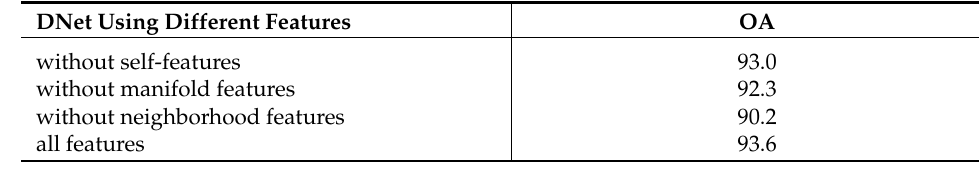
Table 7. Classification accuracy of DNet using different features on ModelNet40 dataset.